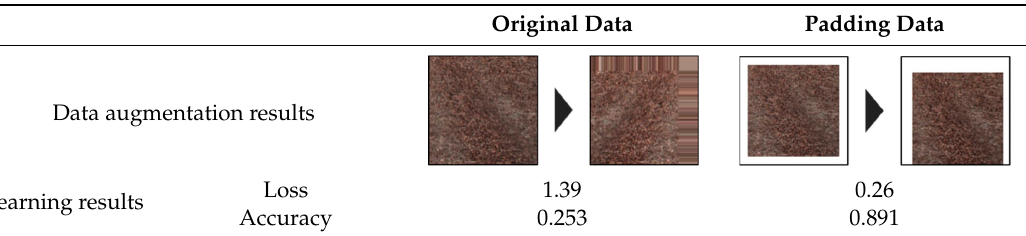
Table 4. Data Augmentation and Learning Results.